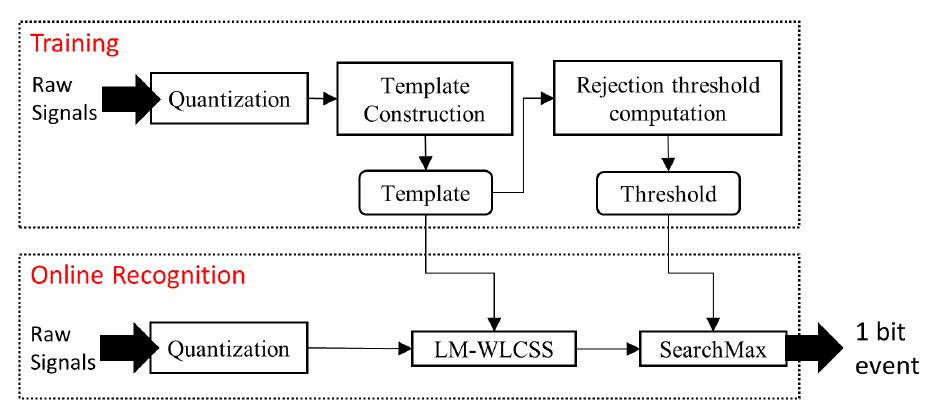
Figure 1. A binary classifier based on the Limited-Memory Warping LCSS